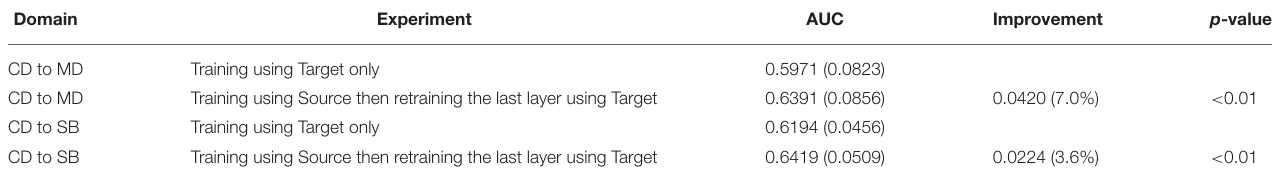
TABLE 3 | Target model vs. transferred